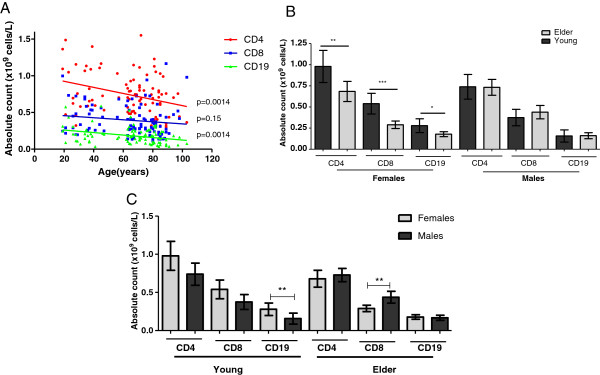
Absolute counts of B and T cells subsets in healthy Cuban subjects. A) CD4, CD8 and CD19 lymphocytes distribution by ages. The cell markers that PBL were stained for are represented on the Y axis in different colors. The linear regression results for CD19+ (green line, n=94, CD8+ (blue line, n=99) and CD4+ cells (red line, n=94) and the p values are shown on the graphs nearby each regression line, p<0.05 indicates statistical differences. B) Absolute counts of CD4, CD8 and CD19 lymphocytes subsets by gender and group of age, significant differences between young (dark gray) and aged individuals (light gray) in each case are labeled. C) Differences between males (dark gray) and females (light gray) by age groups. (*) indicate significant differences by Mann Whitney test (p<0.05).